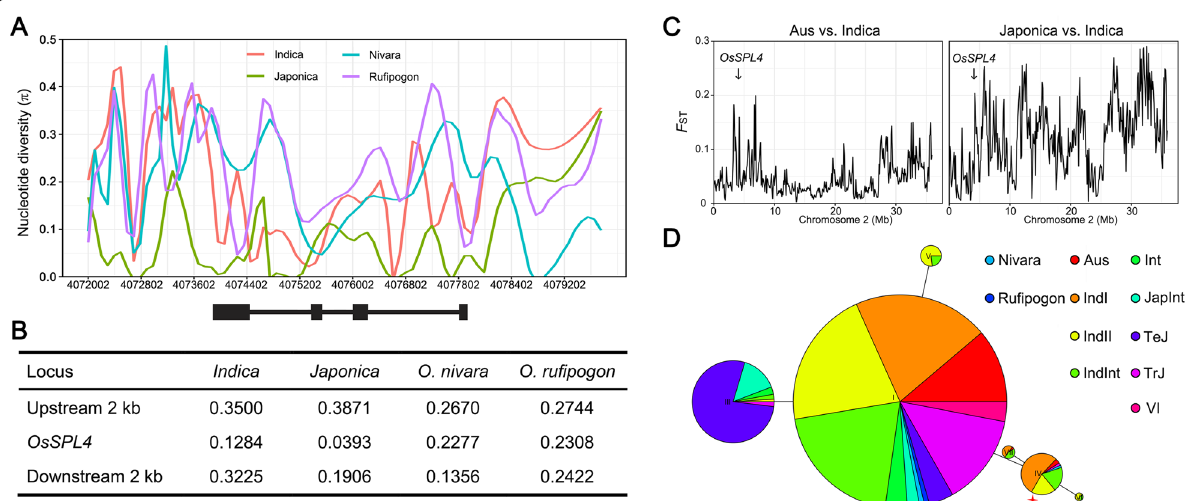
Fig. 8 The nucleotide diversity and haplotype network analysis of OsSPL4 . A Nucleotide diversity (π) analysis in OsSPL4 gene and its flanking region (4 kb) based on the 10 wild and 3010 cultivated rice accessions. Nivara, O. nivara ; Rufipogon, O. rufipogon . Y-axis indicates the π value and x-axis shows the genome location on chromosome 2 in rice. B Average nucleotide diversity (π) of OsSPL4 and its flanking region (2 kb). C Genetic differentiation ( F ST ) across chromosome 2 between different subspecies ( Aus vs. Indica and Japonica vs. Indica ). A total of 592 rice accessions were used for analysis, including 46 aus , 295 indica and 156 japonica rice from RiceVarMap database, respectively. D Haplotype network of OsSPL4 among 10 wild and 592 cultivar rice accessions. Only haplotypes found in more than 10 rice accessions were used to construct the haplotype network. Each circle represents a haplotype and circle size is proportional to the haplotype frequency. Different colors refer to different rice subpopulations. Red star corresponds to OsSPL4 A92V . IndI, indica I; IndII, indica II; IndInt, indica intermediate; Int, intermediate group between indica and japonica accessions; JapInt, japonica intermediate; Nivara, O. nivara ; TrJ, tropical japonica; TeJ, temperate japonica; Rufipogon, O. rufipogon . VI, intermediate group between indica and japonica /